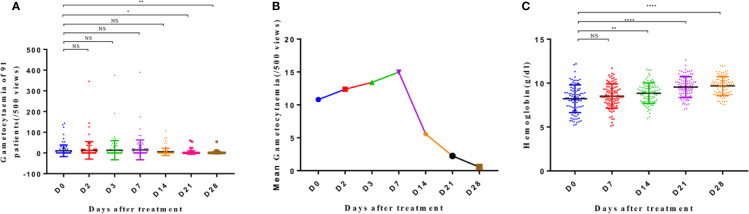
Gametocytemia (A), mean gametocytemia (B), and hemoglobin level (C) of patients from day 0 to day 28. The significance levels are shown as significant (****: p < 0.0001; **: p < 0. 01; *: p < 0. 05) and nonsignificant (NS). The gametocytemia and hemoglobin level of different groups were analyzed with one-way ANOVA and multiple comparisons. Error bars show the standard error of the mean (SEM).